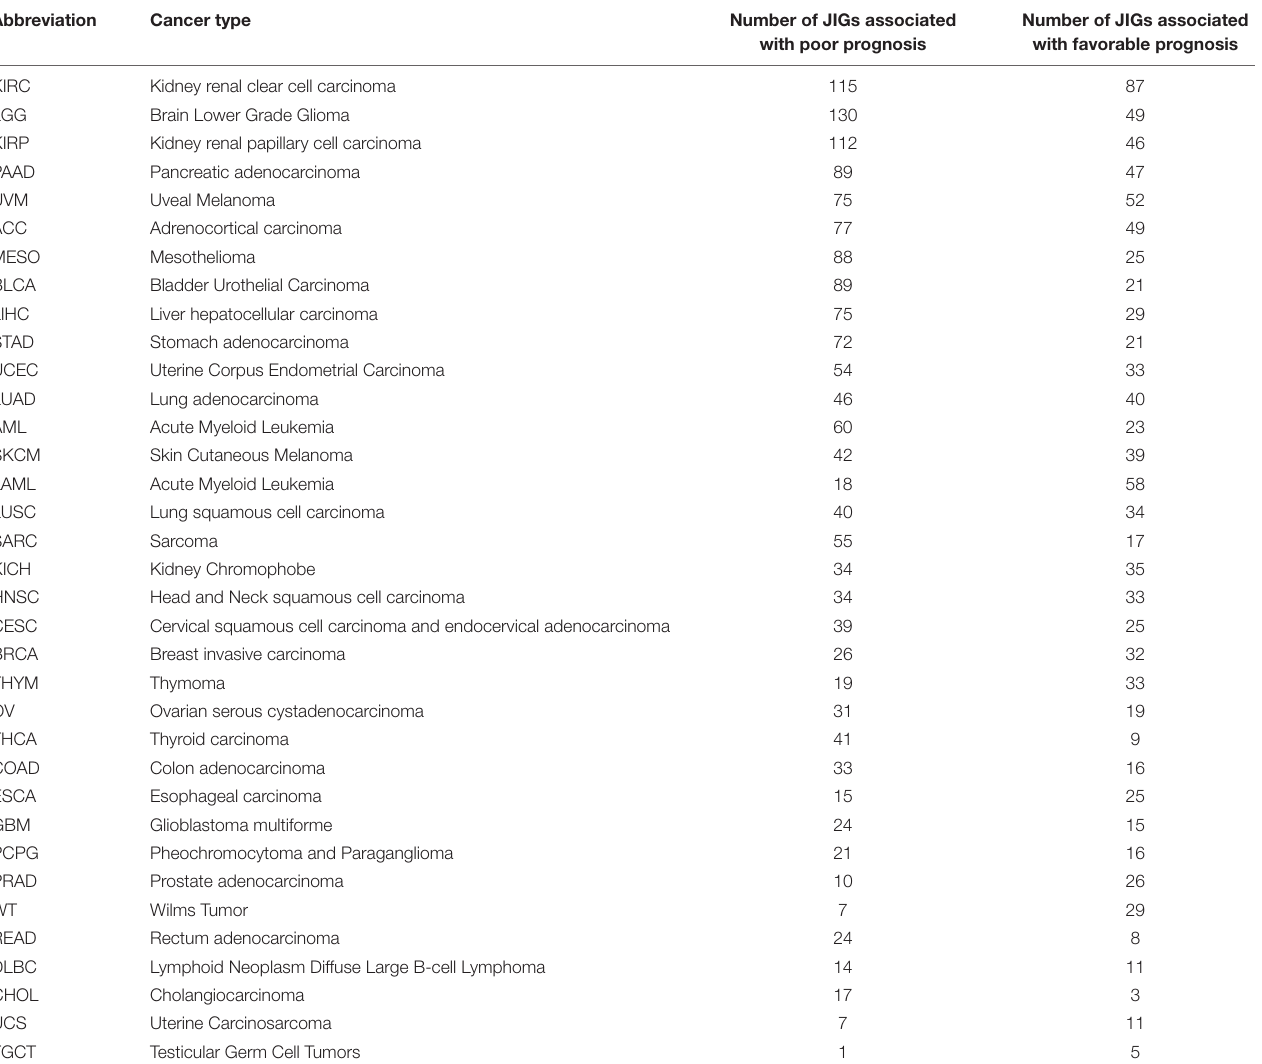
TABLE 1 | Effects of JIGs on cancer patient prognosis (in descending order of total number of JIGs that affect each cancer type).